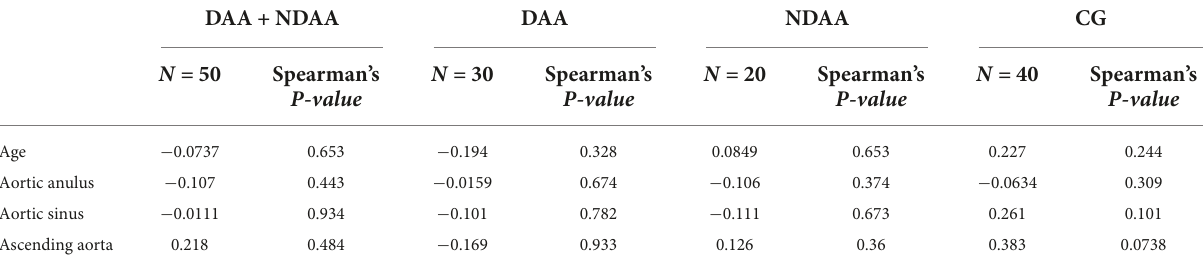
TABLE 3 Spearman’s correlation analyses for TGF- β 1 concentration vs. age and ascending aorta, aortic sinus, and annulus size according to aortic dilatation.